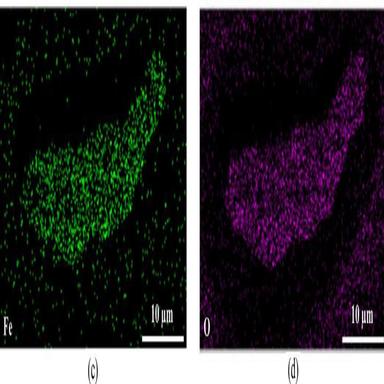
(a) Scanning electron microscope and Energy-dispersive X-ray spectroscopy mapping of: (b) Al, (c) Fe, and (d) O distribution of the impurities in Al-based alloy.